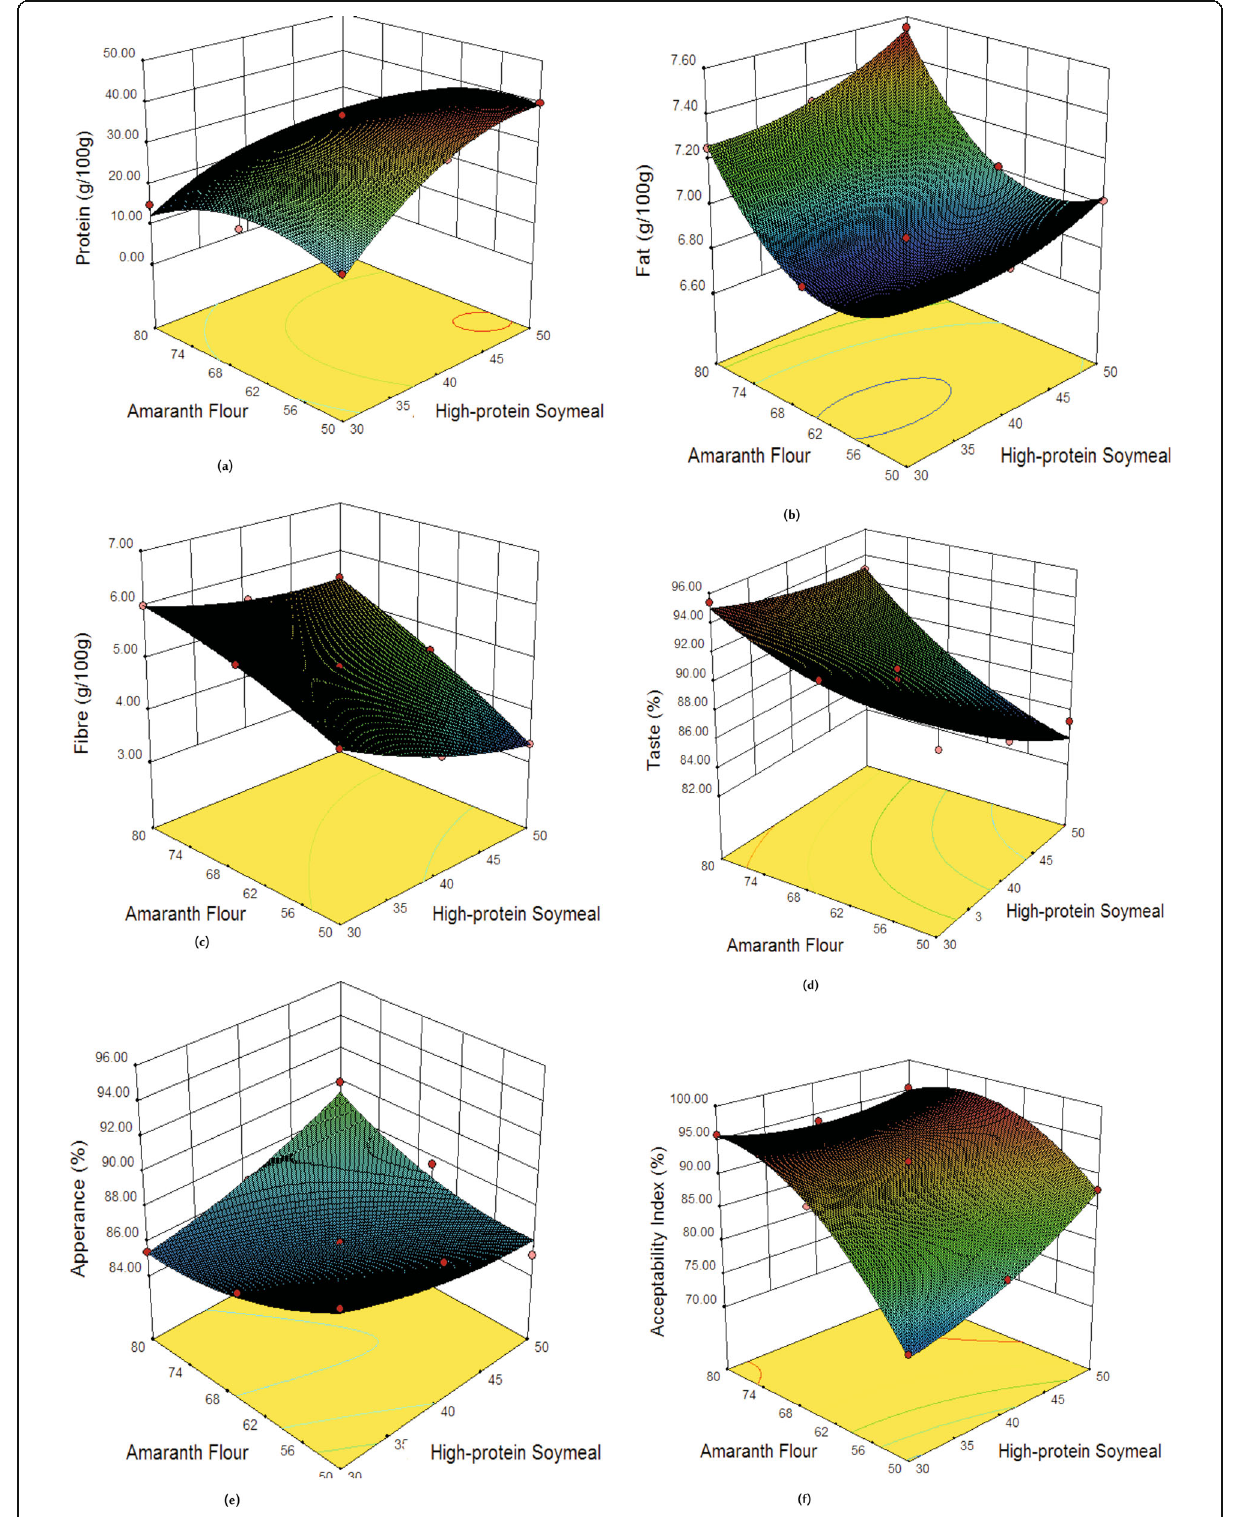
Fig. 2 Response surface plots for consumer-ready flake produced at optimal condition ( a ) protein ( b ) fat ( c ) fibre ( d ) taste ( e ) appearance ( f ) acceptability